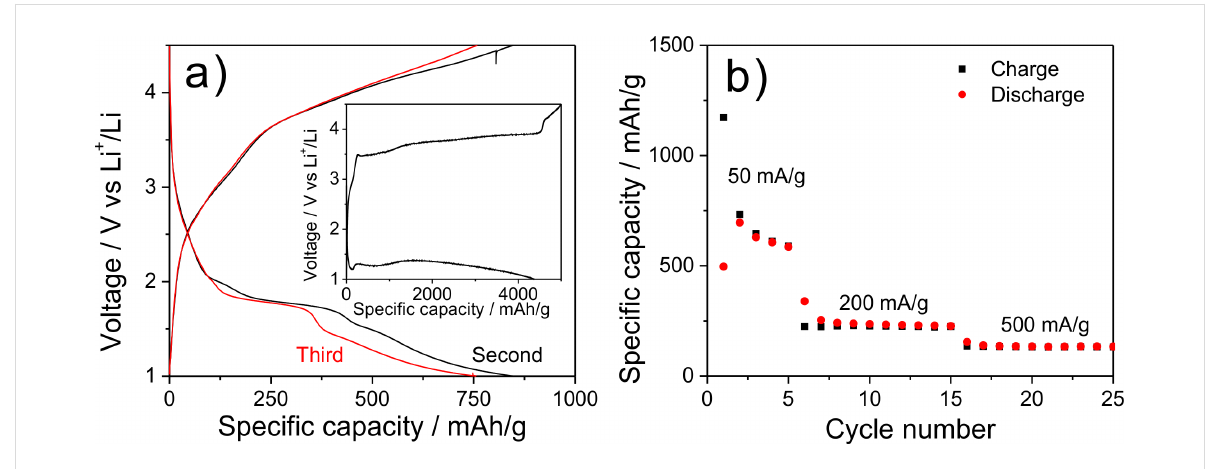
Figure 4: The electrochemical performance of FeF 2 @TRGO-400 as cathode material for lithium-ion batteries. (a) The galvanostatic charge/dis- charge profiles at a current of 50 mA/g. The inset is the profile of the first cycle. (b) The rate performance after an activation over three